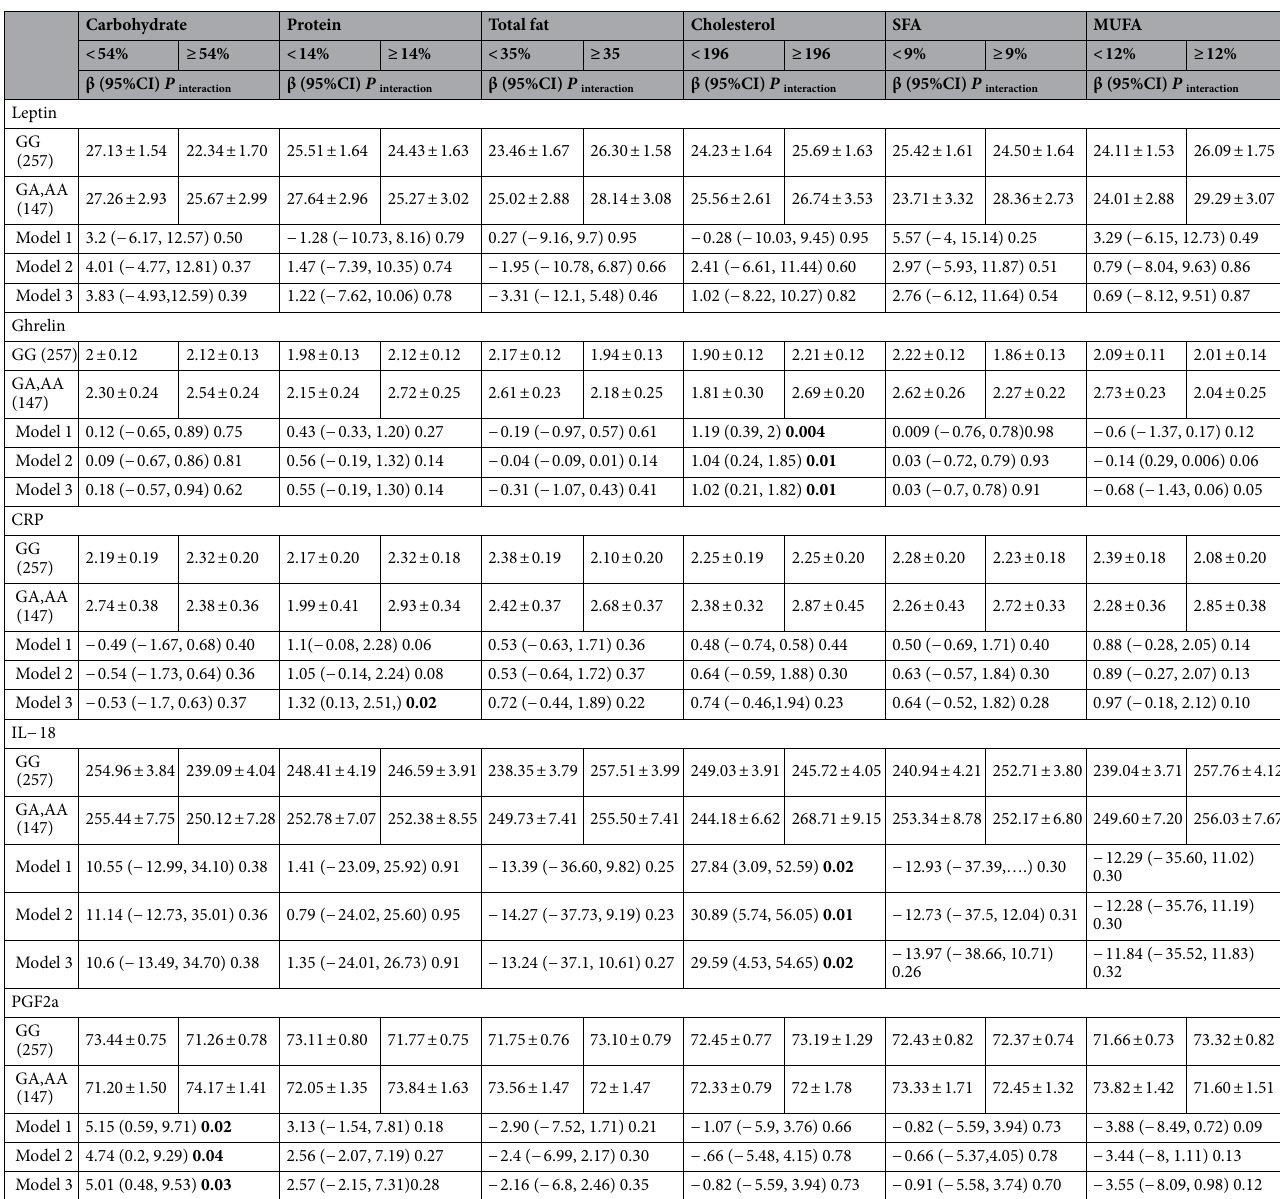
Table 4. Interactions of macronutrients intakes and ApoB EcoRI genotype on leptin, ghrelin and inflammatory markers. CRP C-reactive protein, IL18 interleukin 18, PGF2α prostaglandinF2α. GG genotype is considered as a reference. Low median intakes of macronutrients considered as a reference. P values for the interaction obtained in multivariate models using GLMs. Model 1: unadjusted; Model 2: adjusted for age, gender, physical activity, alcohol consumption and lipid-lowering medications; model 3: adjusted for variables in model 2 plus for smoking, total energy intakes and fiber